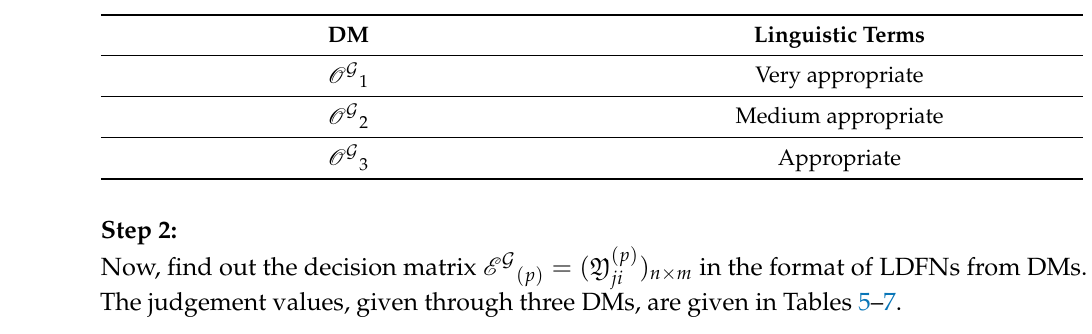
Table 5. Assessment matrix acquired from O G 1